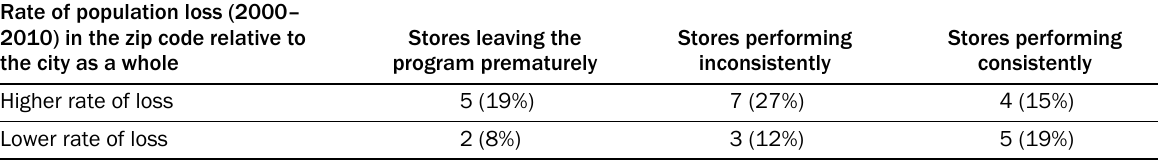
Population data source: U.S. Census Bureau,